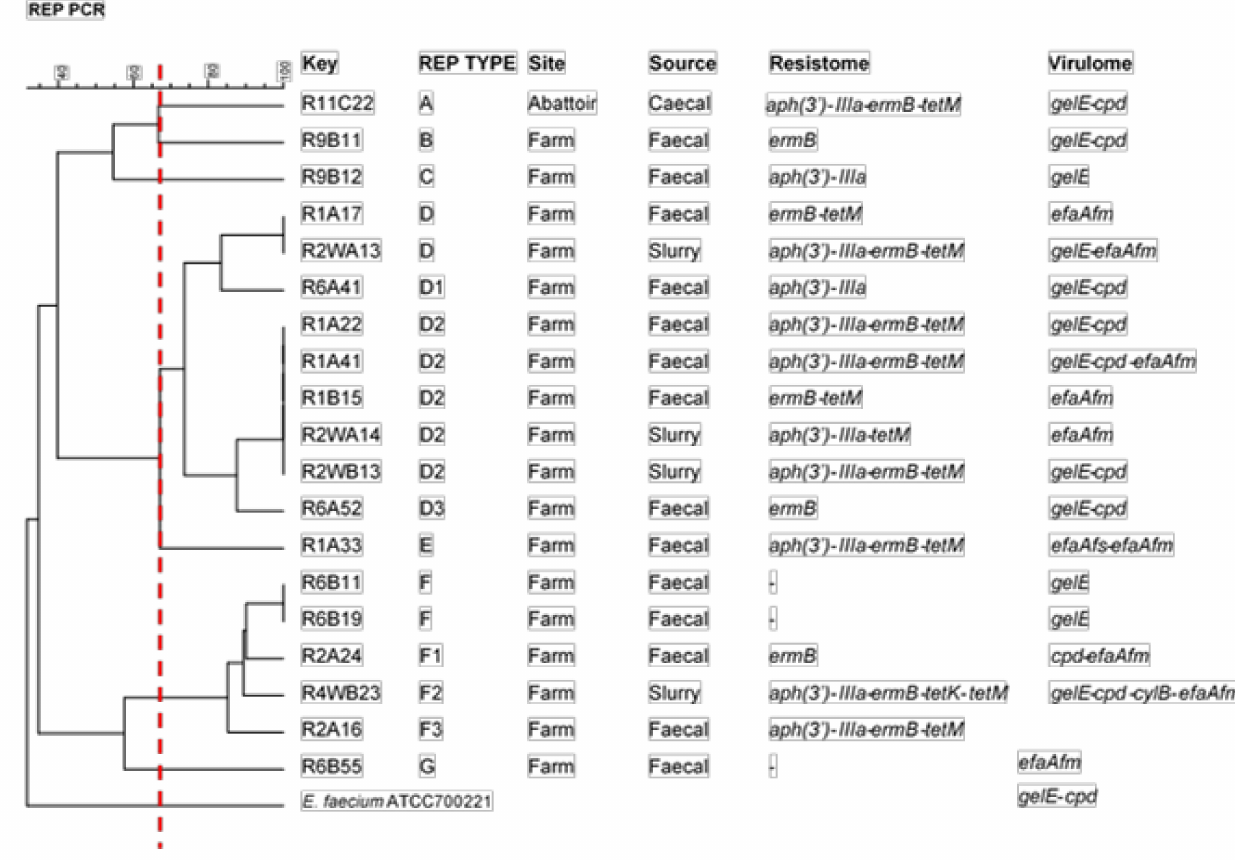
Figure 4. Dendrogram showing REP-types of E. faecium isolates, based on ≥ 70% similarity index recovered along the farm-to-fork continuum. E. faecium ATCC 700221 was used as the reference